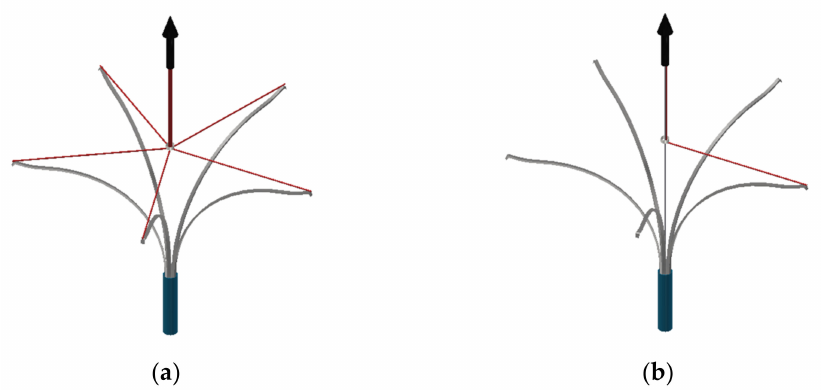
Figure 2. Schematics of the measurement of forces exerted by the Flebogrif cutting elements: ( a ) Mea- surement of the total force of all cutting elements; ( b ) Measurement of the force of a single cutting